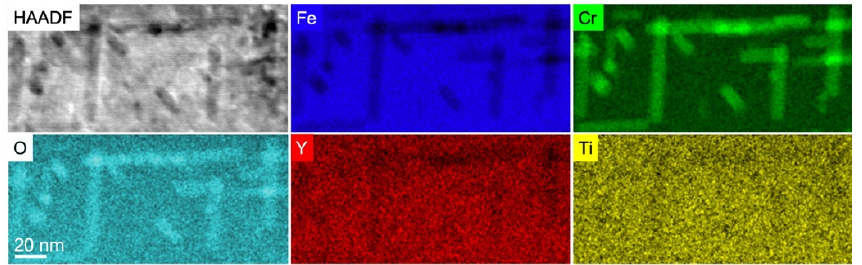
Figure 2. STEM-HAADF and STEM-EDX imaging of FeCr implanted with Ti, Y, and O ions in the sequential order Ti → Y → O and subsequently annealed at 800 ◦ C for 2 h. The oxide precipitates are observed with a dark contrast on a lighter background in the STEM-HAADF